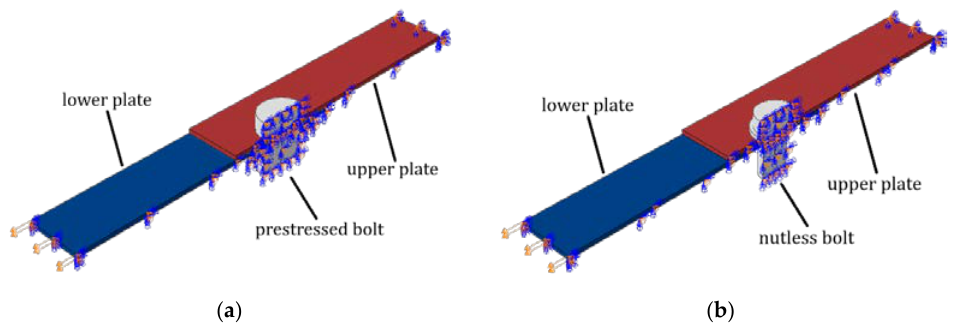
Figure 5. Boundary conditions for lap connections with ( a ) the prestressed bolt with a nut and ( b ) the nutless bolt.